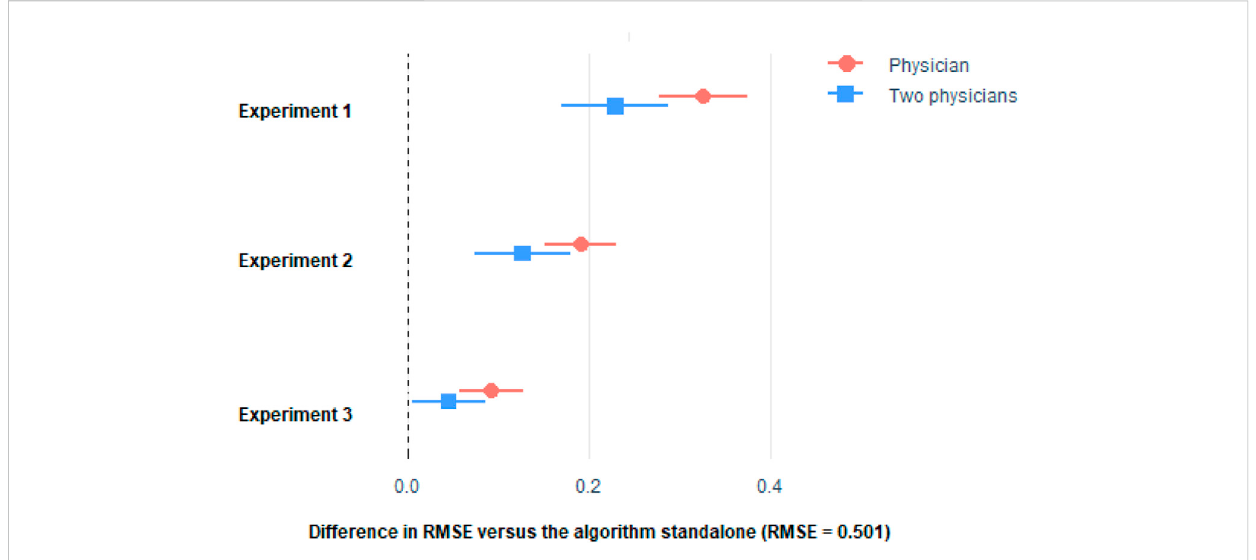
FIGURE 3 Difference in RMSE with respect to the algorithm of the strati fi cation made by the physicians only, and the mean of two physicians. Horizontal lines represent the 95% CI of the difference. See Supplementary Table SA of the Appendix for the procedure to build the 95% CI.